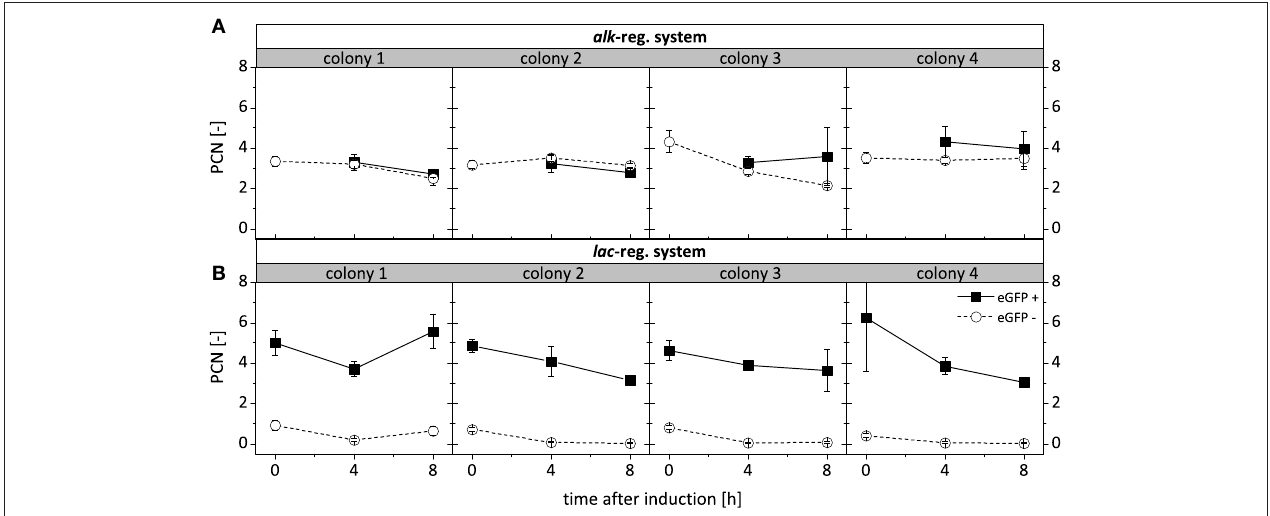
FIGURE 6 | Average PCN per cell after 0h, 4h and 8h of induction of P. putida DOT-T1E recombinants. One thousand cells originating from the 8 respective cultures visualized in Figure 5 expressing the fusion construct styA-eGFP under control of the alk - (A) and the lac - (B) regulatory systems were sorted according to defined gates (Figure S9) for fluorescing (eGFP + ) and non-fluorescing (eGFP − ) cells. PCNs were determined in quadruplicates for each subpopulation and are presented as an average value with standard